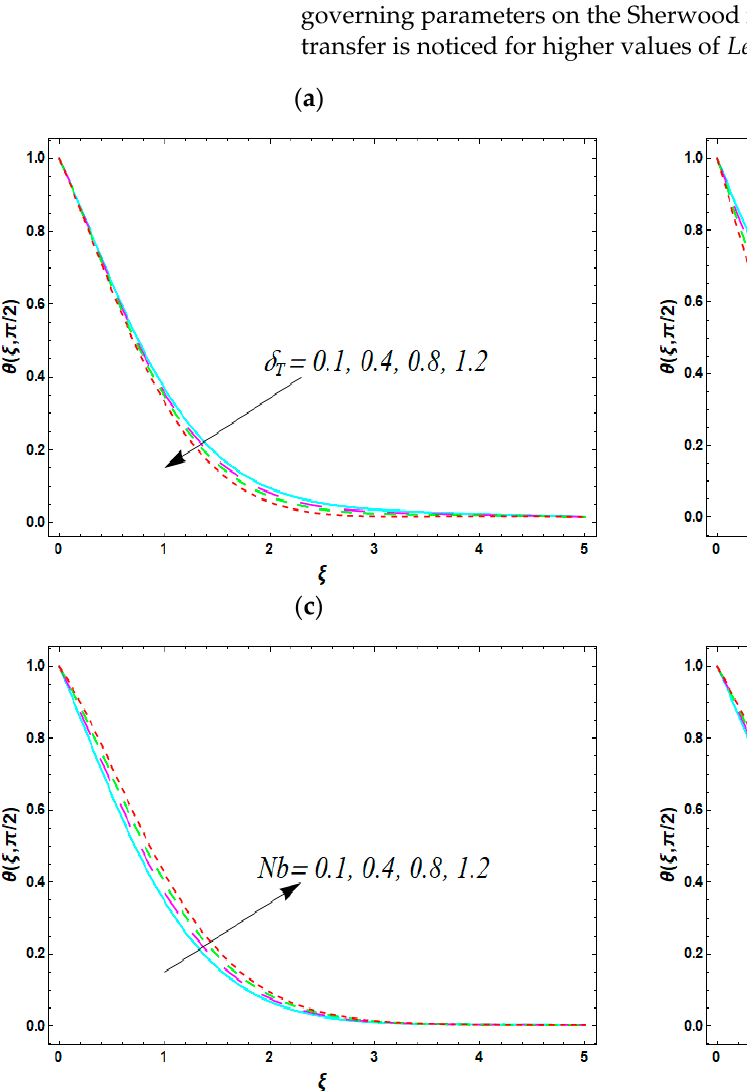
T , ( b ) Pr, ( c ) N b and ( d ) Rd